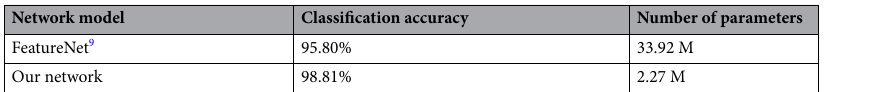
Table 6. Performance comparison using our dataset between the proposed network and